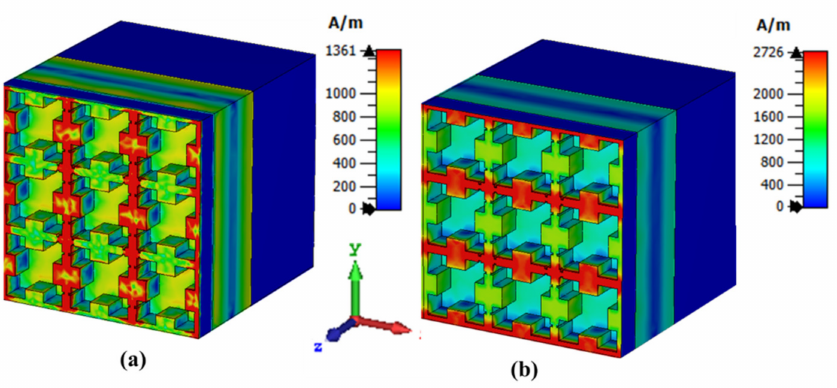
Figure 8. Surface plasmon density at 4.4754 THz ( a ) TE mode ( b ) TM mode.